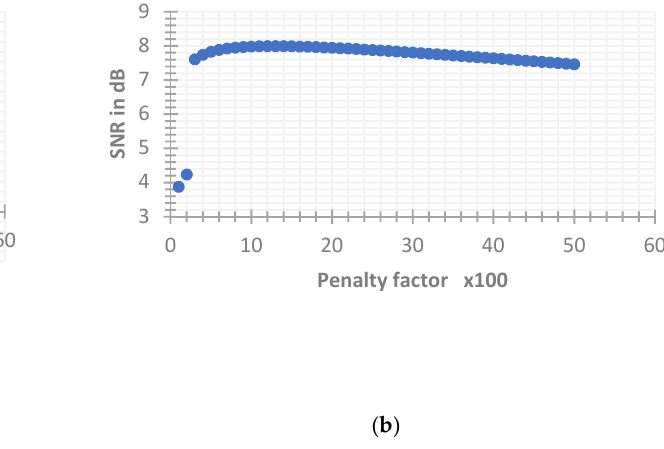
Figure 13. Reconstructed SNR under different original SNR. ( a ) Reconstructed SNR at − 6 dB. ( b ) Reconstructed SNR at 1 dB.